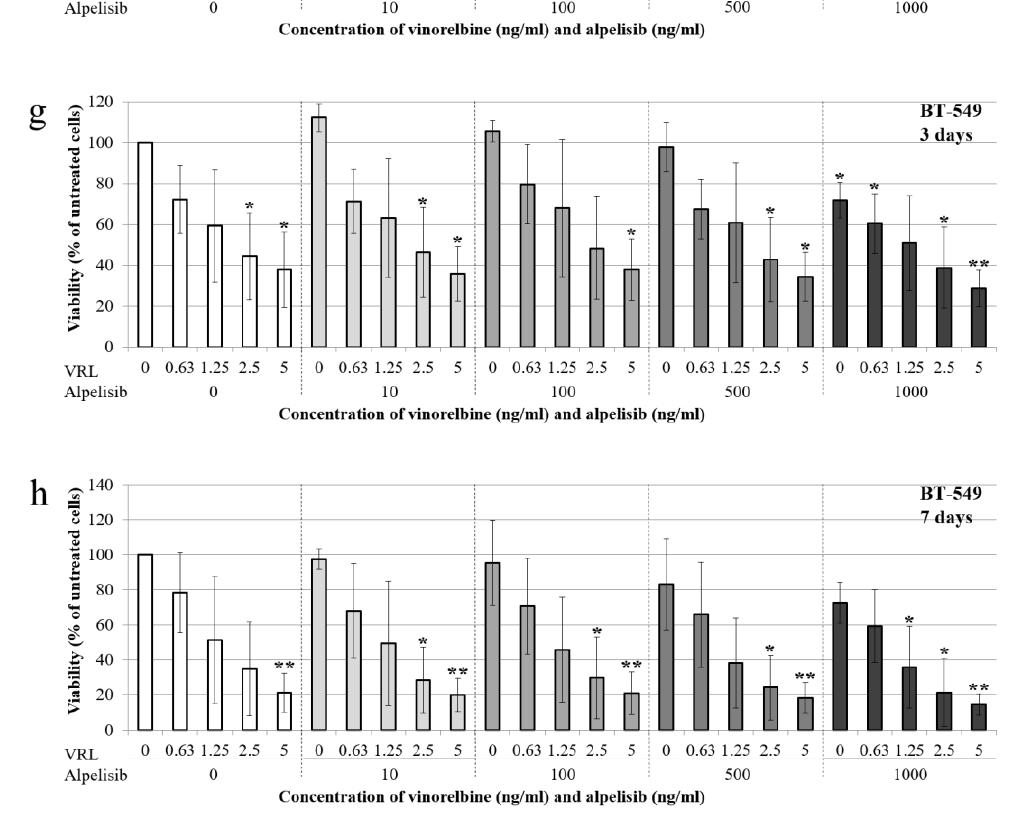
Figure 1: Effects of low-dose vinorelbine plus alpelisib on cell viability of the MCF-7 ( a , b ), T-47D ( c , d ), MDA-MB-231 ( e , f ) and BT-549 ( g , h ) cell line. Alamar blue assay was used to measure cell viability after 3 and 7 days of treatment with low-dose vinorelbine plus alpelisib. The results are shown as the mean ± standard deviation of three separate experiments. Statistical significance was assumed at * p<0.05, ** p<0.01 and ***